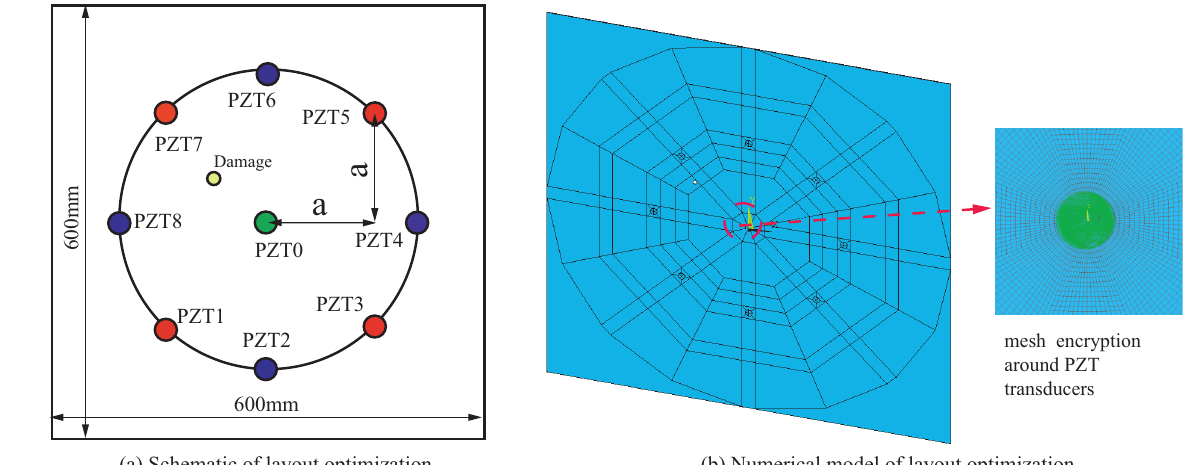
Figure 19. ( a ) The schematic of layout optimization, and ( b ) the numerical model.